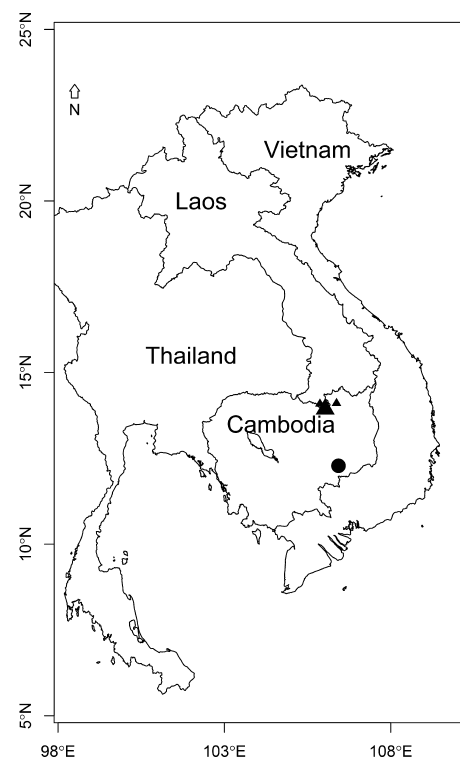
Fig. 3. Distribution of Kaempferia nemoralis Insis. sp. nov. ( ● ) and Kaempferia pascuorum Insis. sp. nov. ( ▲ ). Type locality of Kaempferia pascuorum Insis. sp. nov. ( ▲